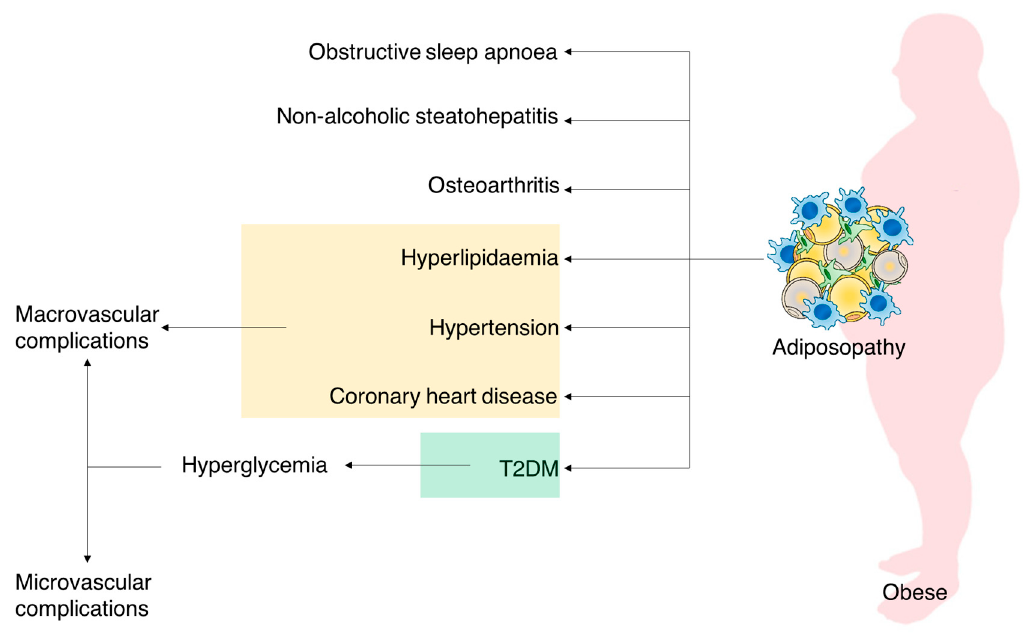
Figure 1. Illustration of the wide-ranging effects of adiposopathy.